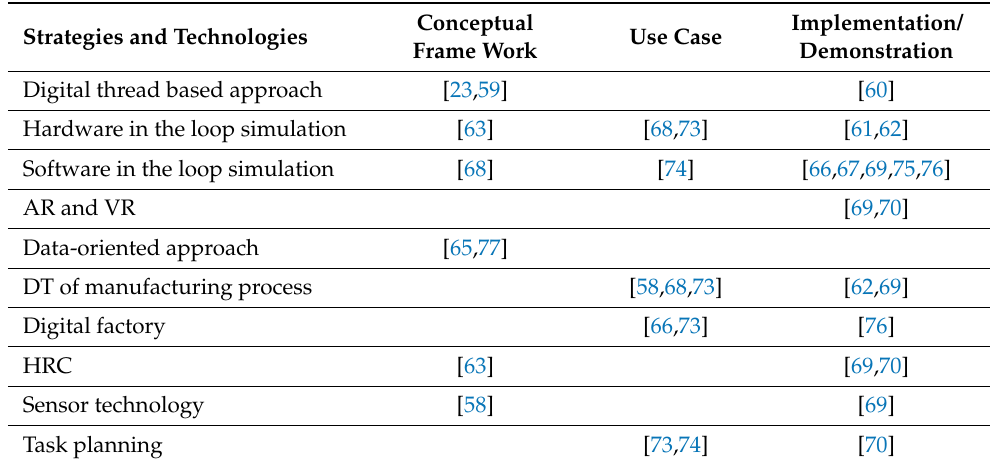
Table 2. Summary of strategies and technologies that can potentially be used for building a simulation based